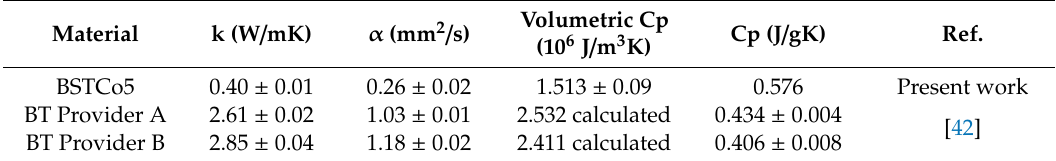
Table 3. Thermal conductivity, thermal di ff usivity, volumetric specific heat, and specific heat determined at room